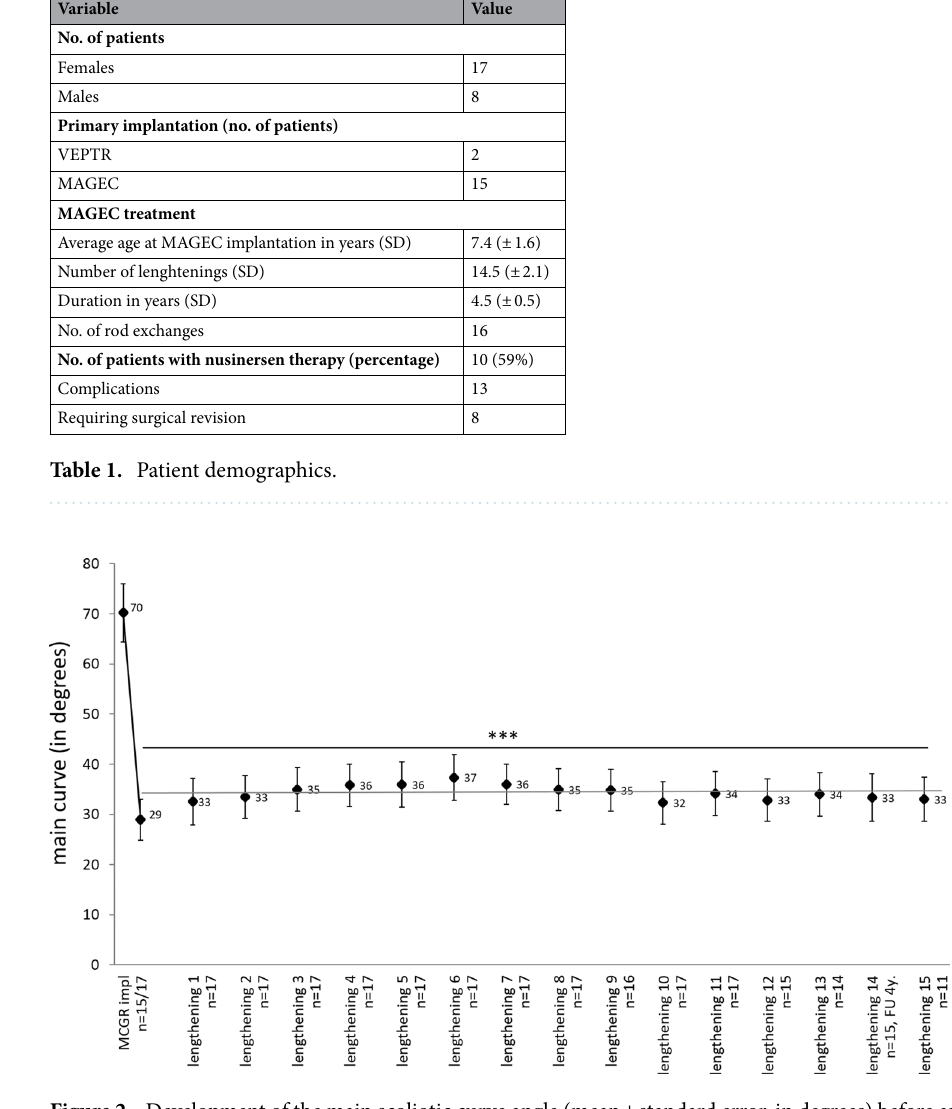
Figure 2. Development of the main scoliotic curve angle (mean ± standard error, in degrees) before and after MCGR implantation and after every lengthening procedure with n > 10. Significance (*** p < 0.001) between the time points and the initial value was evaluated with paired Student’s t-test. The regression line is drawn for all values post implantation. Patients have a minimum follow-up of four years, but radiographs were not taken at each evaluation and therefore numbers